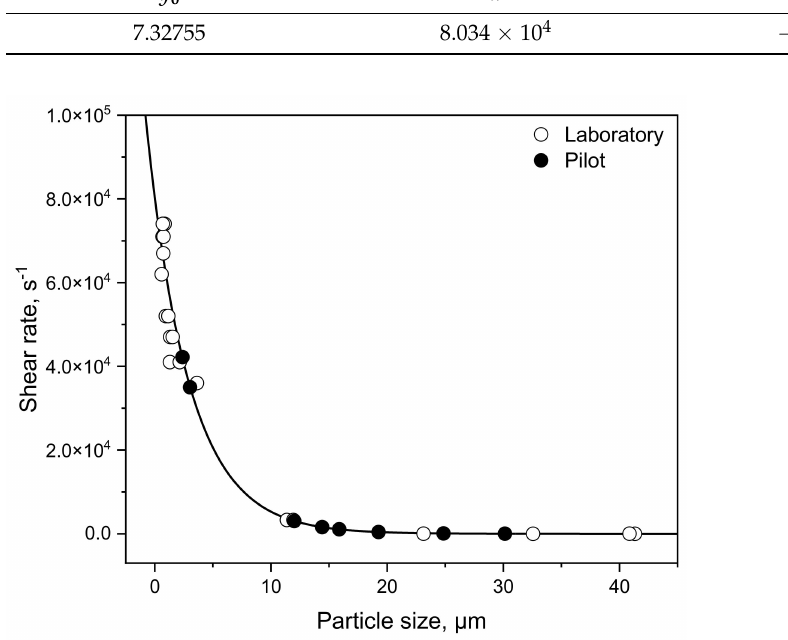
Figure 9. Correlation between calculated shear rates and observed particle size in laboratory scale of MC88 and MPC85 (white circles) homogenized via colloid mill. Black circles represent the particle sizes observed in pilot scale after homogenization with shear pump. Corresponding shear rates are calculated with the correlation function. The correlation coefficient R 2 of the fit was ≥